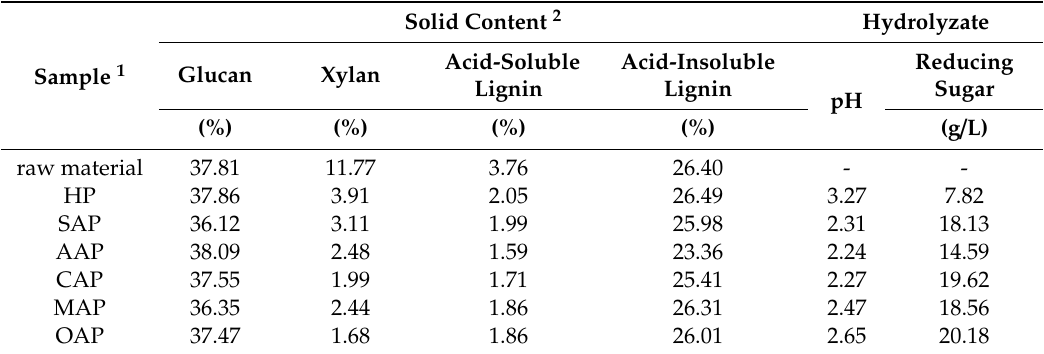
Table 3. Raw material composition and pretreatment results of di ff erent